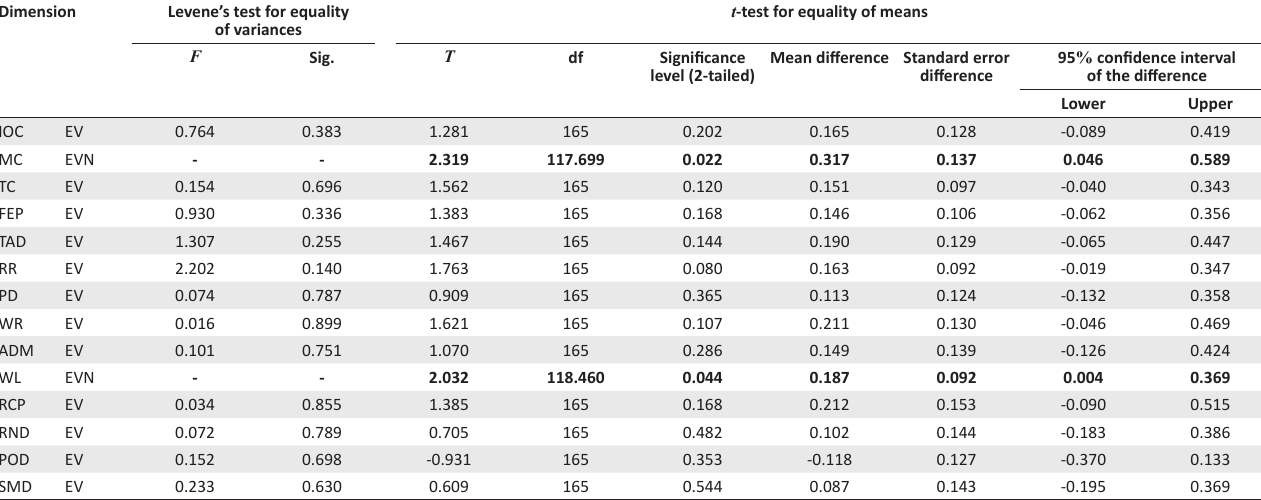
t -test for equality of means